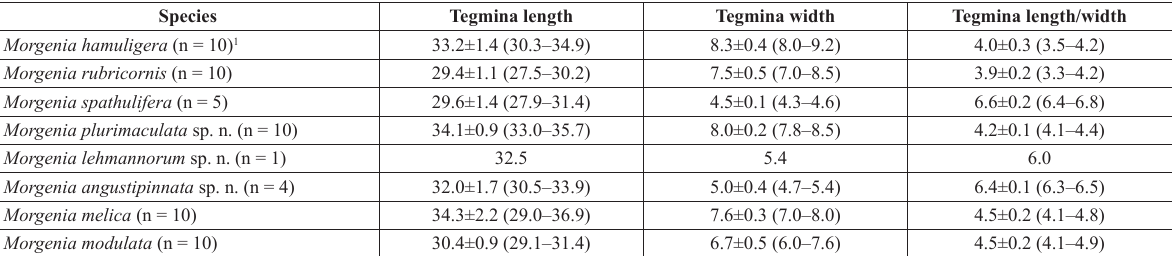
Table 1. Measurements of tegmina length and width and ratio of tegmina length/width of the eight species currently known in the genus Morgenia